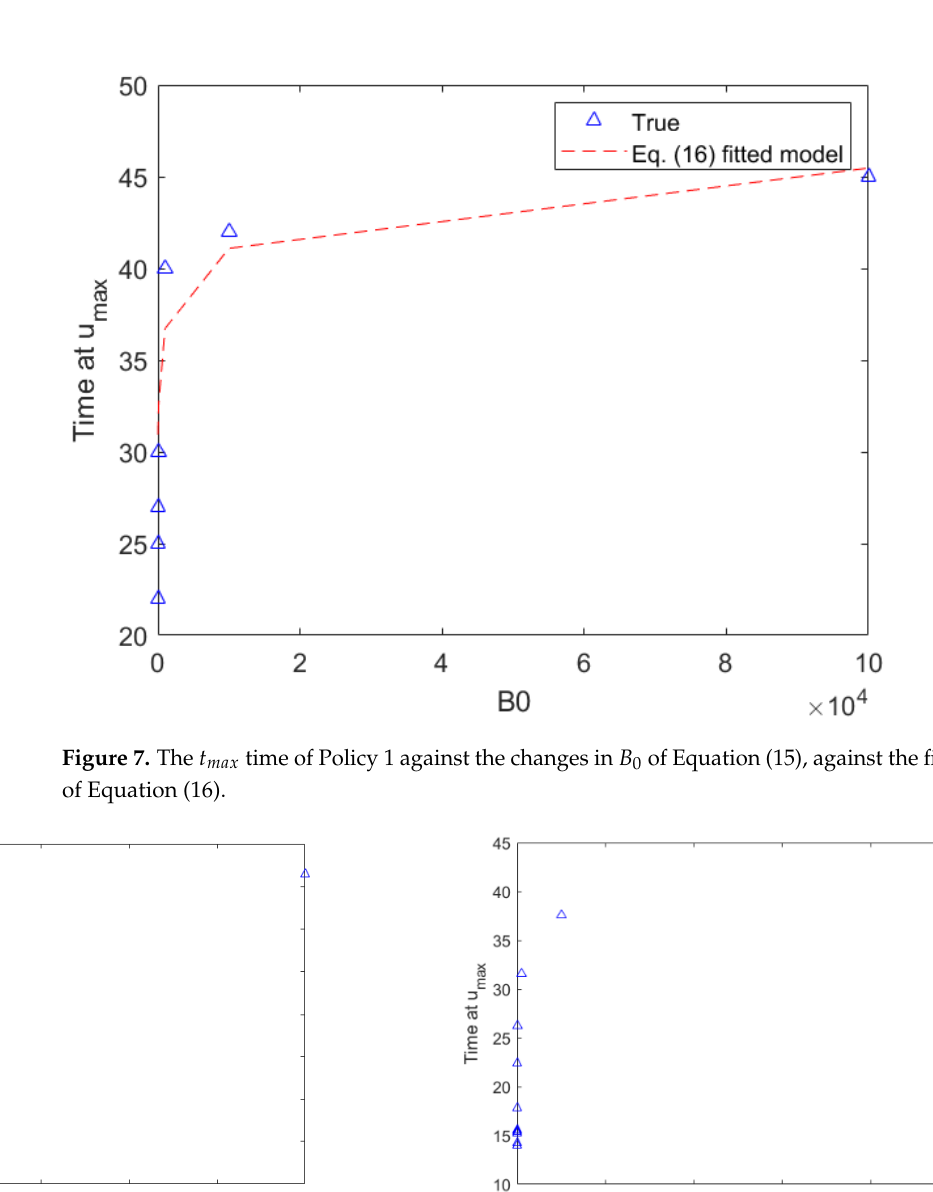
Figure 8. The max t time of Policy 2 against the changes in 0 B of Equation (15). ( a ) Control effort 1 u ; ( b ) Control effort 2 u . Figure 8. The t max time of Policy 2 against the changes in B 0 of Equation (15). ( a ) Control effort u 1 ; ( b ) Control effort u 2 . Figure 9 shows matches between the models of Equations (19) and (20) against the plot of Figure 8. The coefficient of determination for these matches are 0.9869 and 0.9738, respectively. The mean absolute error for the case of u 1 is 0.4066, whereas the corresponding mean absolute error for the case of u 2 is 1.0603. These matches, along with the coefficients of determination, serve to demonstrate that the logarithmic function is again a good model to describe the control effort change with respect to B 0 for both